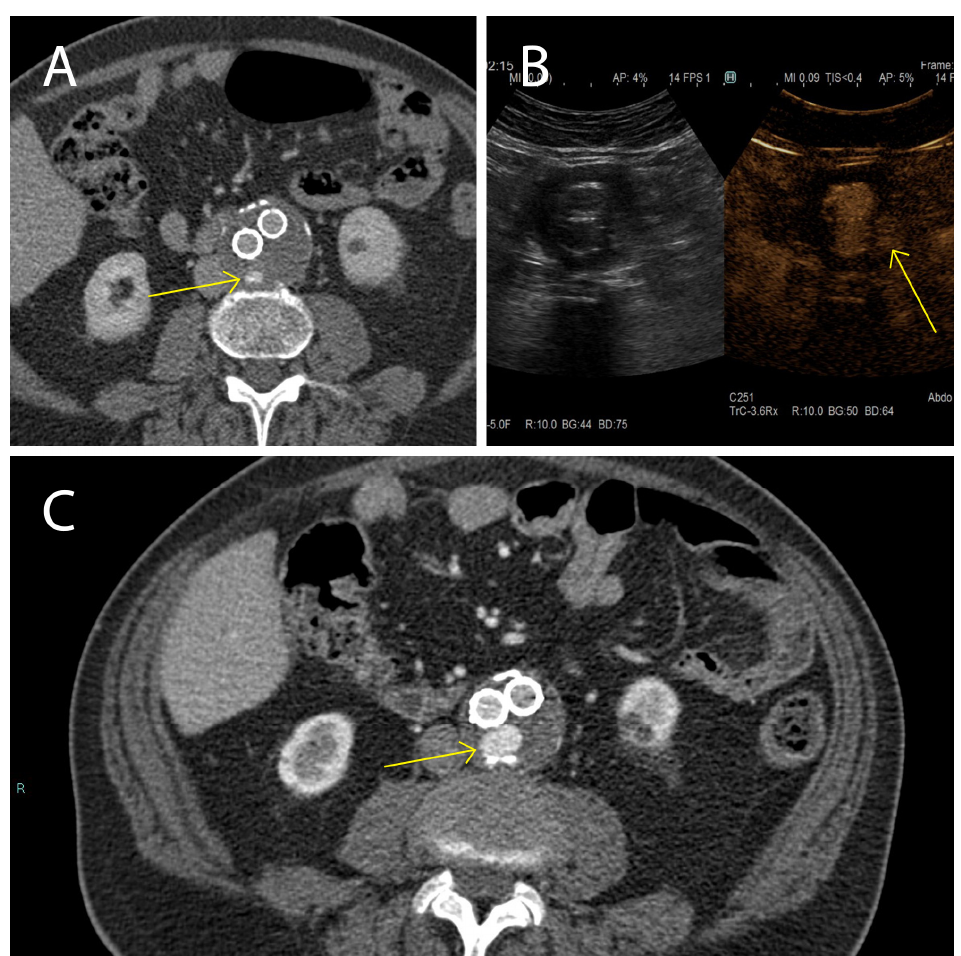
Figure 7. Presence and persistence of an endoleak. In these images a type II (yellow arrow) was evidenced using CTA 1 month after EVAR intervention, ( A ) monitored during the follow-up after 6 months using CEUS ( B ), and again using CTA 12 months after EVAR implantation ( C ). It has been demonstrated that EVs derived from platelets and endothelial cells have pro-thrombotic and atherogenic potential and EVs stemming from the endothelium are associated with different cardiovascular diseases and have great potential as biomarkers in this context [44,70–71]. Furthermore, it is known that platelets are activated in AAA [72], and EVs stemming from activated platelets are involved in the pathogenesis of AAA [73]. It is known, that in patients affected by aortic aneurysm, platelet-derived EVs carry increased levels of ficolin-3, compared to healthy subjects, and these EVs were associated with aneurysm progression [74]. Ficolin-3 induces the activation of the complement sys- tem through the lectin pathway [75]. The complement system, in turn, mobilizes innate immunity, and thereby induces inflammation, which is the underlying cause of different cardiovascular disorders, including AAA [73,75]. In line with these findings, we observed a significant decrease in circulating EVs derived from platelets during the first 12 months after EVAR treatment for AAA, specifically between the first follow-up and 6 months after EVAR intervention. Such a decrease in EVs is therefore associated with a not correctly excluded AAA using EVAR. This condition is characterized by continuous thrombus remodeling and intense crosstalk between the coagulation cascade and the complement system [74]. Therefore, the site of the endoleak resembles a microenvironment characterized by